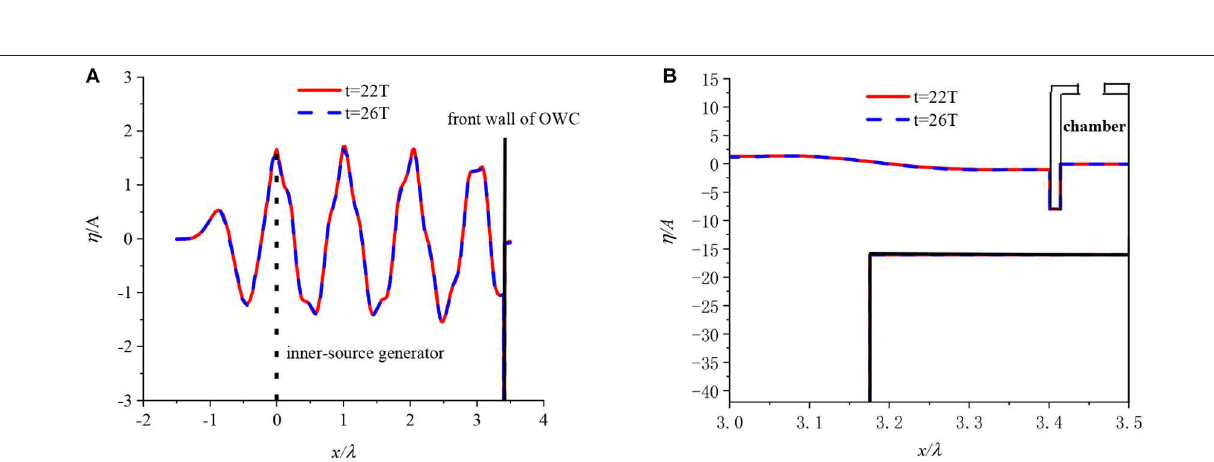
Frontiers in Energy Research |